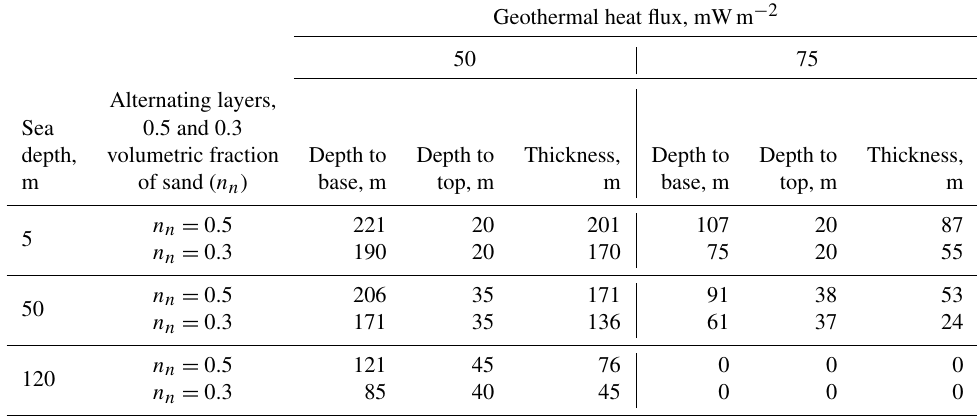
Table 6. Modeling results for depths to permafrost top and base and permafrost thickness for alternating sand and clayey silt (clay) layers, NE area.